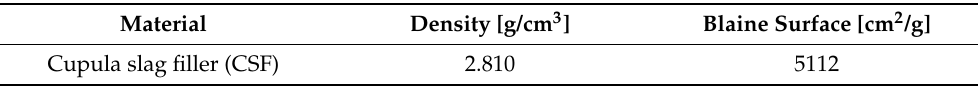
Table 6. Physical properties of cupola slag.